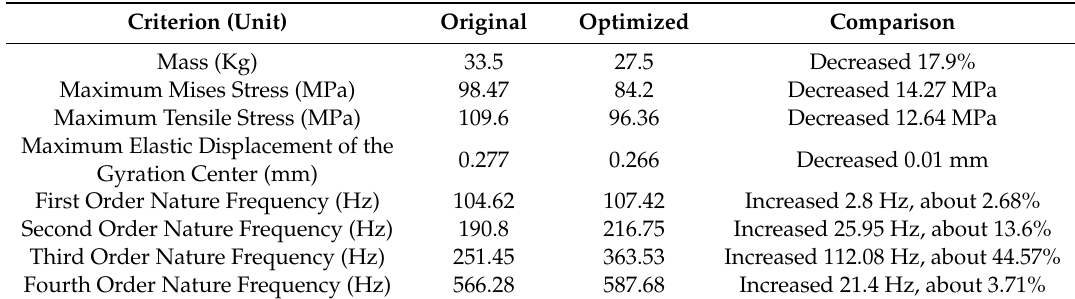
Table 7. Criteria comparison of the upper arm before and after